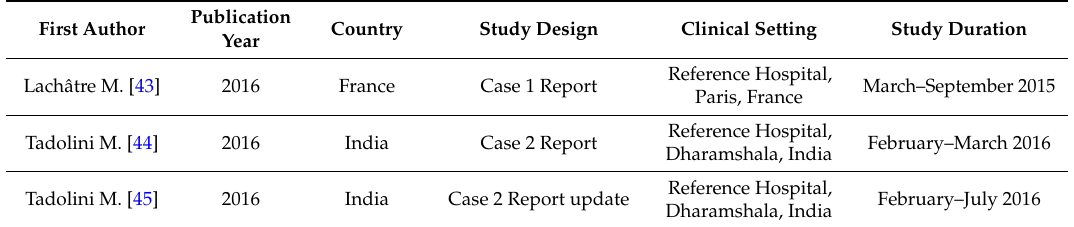
Figure 1. PRISMA (Preferred Reporting Items for Systematic Reviews and Meta-Analysis) 2009 Flow Diagram. Table 1. Epidemiological characteristics of the selected studies.